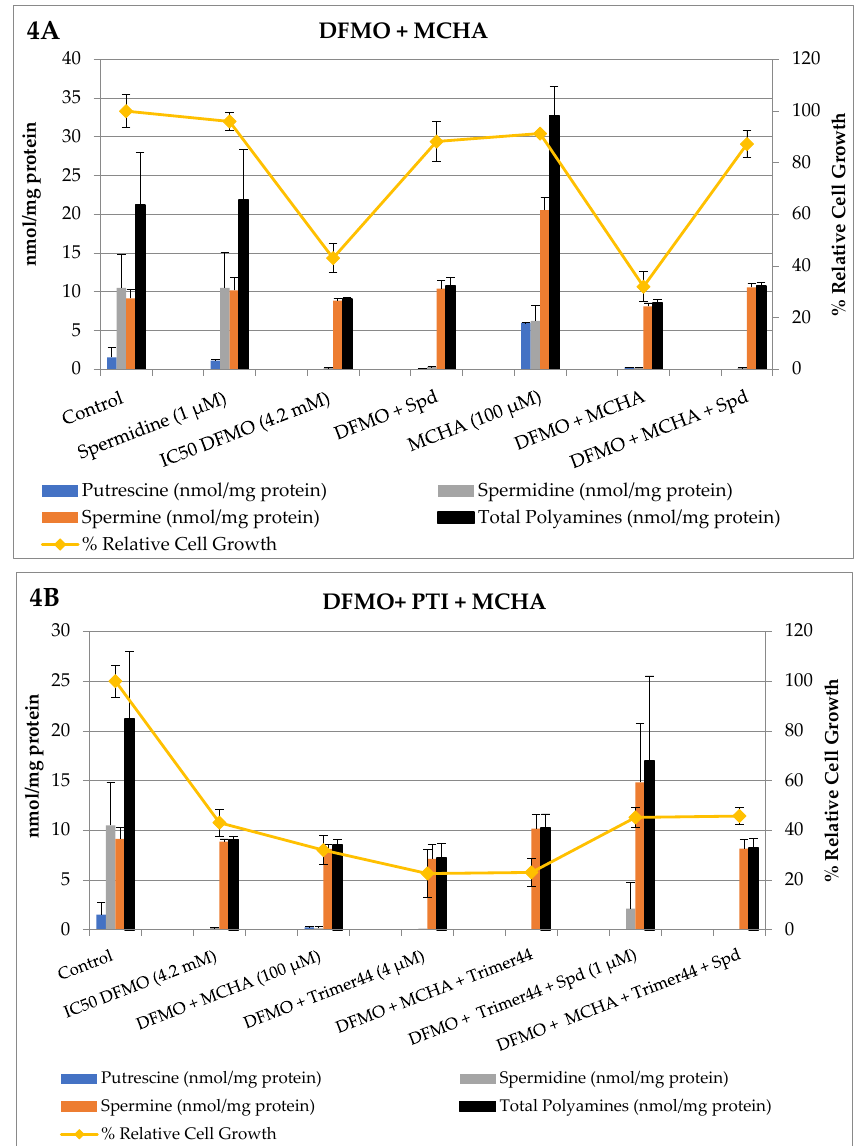
Figure 4. Single and combination therapies in L3.6pl cells with the spermidine synthase inhibitor, MCHA, at 100 µM. Altered polyamine pools (expressed as nmoles polyamine/mg protein) and L3.6pl relative % cell growth (vs. an untreated control) were observed after 72 h incubation. Controls were run in parallel, polyamine levels were determined in duplicate, and % cell growth determined in triplicate. The concentrations of compounds were: DFMO (4.2 mM), MCHA (100 µM), trimer44 PTI (4 µM), and spermidine (Spd, 1 µM). At these doses only DFMO gave significant reductions in cell growth when tested alone. In Panel A, the reduction in putrescine and spermine was statistically significant ( p < 0.05) compared to untreated controls. Relative cell growth tracked fairly well with total intracellular polyamine pools.